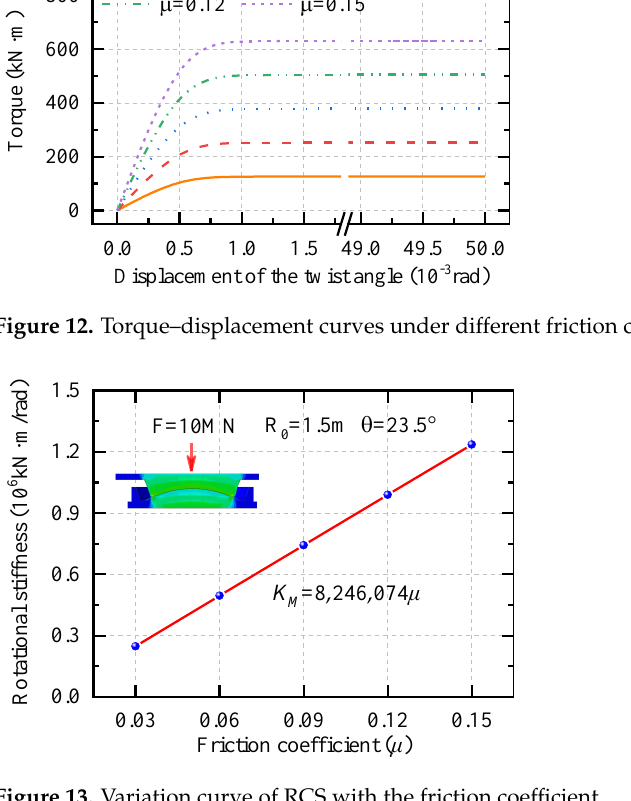
Figure 13. Variation curve of RCS with the friction